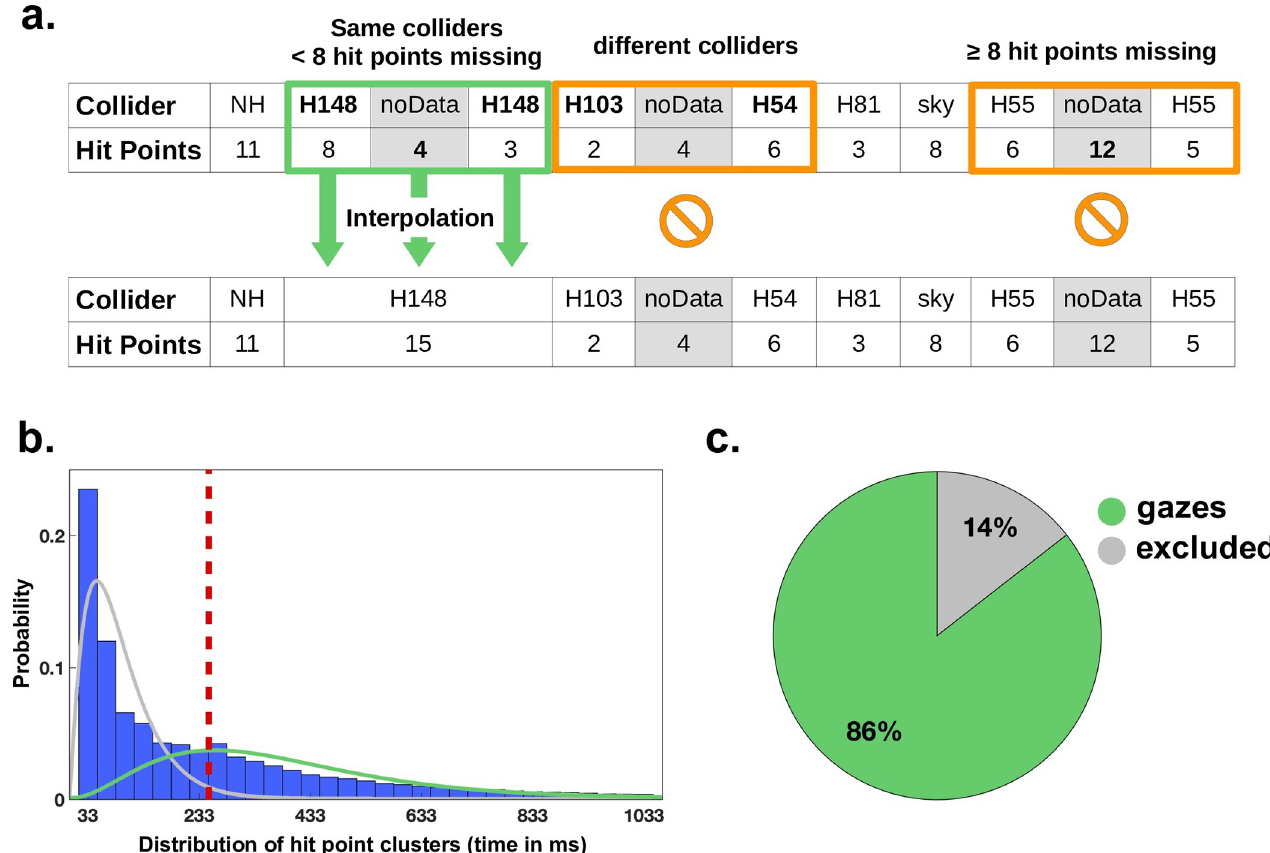
Fig 2. Defining gazes. (a) We interpolate missing data only if less than eight samples are missing consecutively (pupil detection with less than 50% probability) and if these samples occur between two clusters on the same collider. During the interpolation process, these samples are then unified with the two clusters to form a new cluster on the same collider. The first row shows three clusters of missing samples (marked noData), while the second row represents the result of the algorithm. In the first cluster (green box), both interpolation conditions apply: there are fewer than eight consecutive missing data samples (#4) and they are surrounded by two clusters on the same collider. Consequently, these missing samples are interpolated and combined to a new cluster. In the second cluster (1 st orange box) the first interpolation condition applies (#noData samples < 8) but the cluster occurs between clusters on two different colliders (H103 and H54). Therefore, no interpolation is performed. In the third cluster (2 nd orange box) only the second interpolation condition applies. Even though the missing data samples occur between two clusters on the same collider (H55), the first interpolation condition is violated (#noData samples � 8). Consequently, no interpolation is performed. (b) Histogram of hit point cluster length distribution after interpolation. The distribution is visualized between 0 and 1033 ms. The longest hit point cluster on a house has a duration of 18.9 seconds. The ordinate corresponds to the probability of each duration. Since previous work used gamma distributions to model the distribution of fixation durations or response latencies [39,40],we model the two partly overlapping gamma distributions for visualization only, fitting the distributions of the duration of fixations (green) and non-fixation events (grey). The dashed red line marks the separation threshold for gazes. (c) The pie chart shows the result of the gaze classification across all